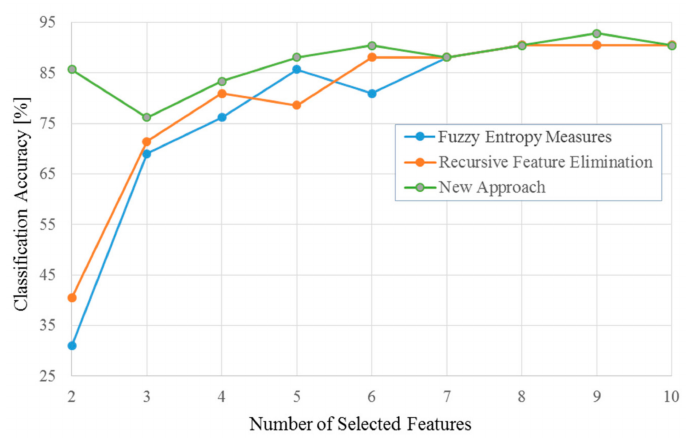
Figure 10. Multi fault classification results of di ff erent feature selection